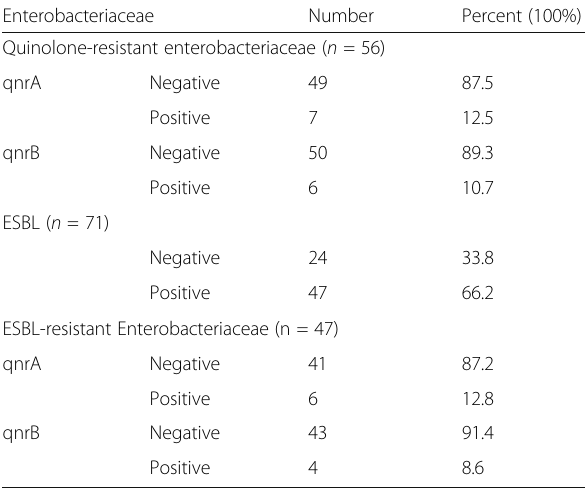
Table 2 qnrA and qnrB genes among quinolone-resistant and ESBL Enterobacteriaceae and prevalence of ESBL production Enterobacteriaceae